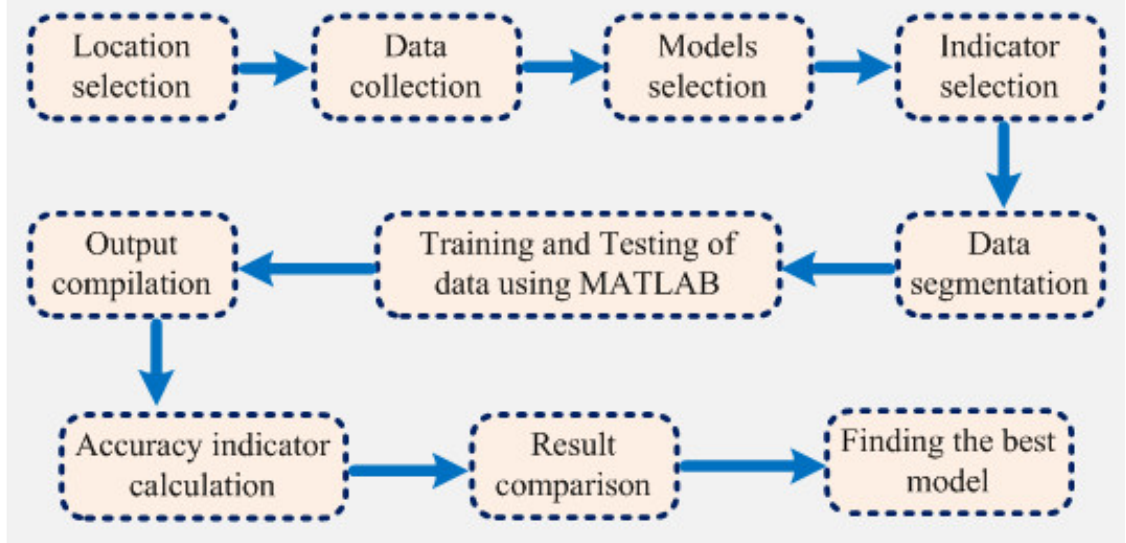
Figure 3. The step-by-step structural outline of the work performed in this manuscript.